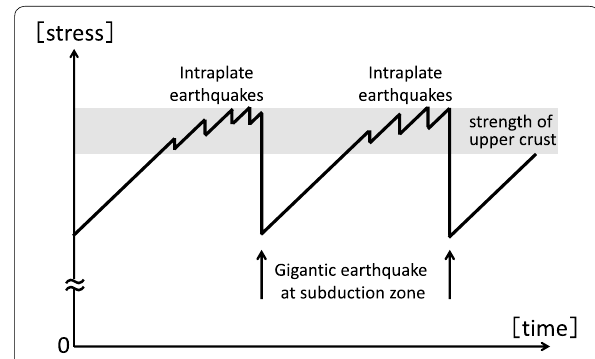
Fig. 4 Conceptual model of the time development of stress in the upper crust of inland Japan. The diagram follows Ikeda (1996) with a modification of the zero stress level; the stress just after a gigantic earthquake was taken to be zero in his original diagram. Ikeda (1996) considers that the stress increase is suppressed by the occurrence of intraplate earthquakes before a gigantic earthquake at